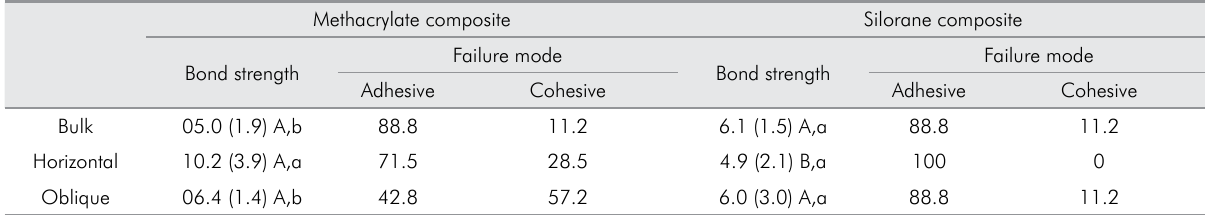
Table. Means (standard deviations) for push-out bond strength (MPa) and percentage of failure modes